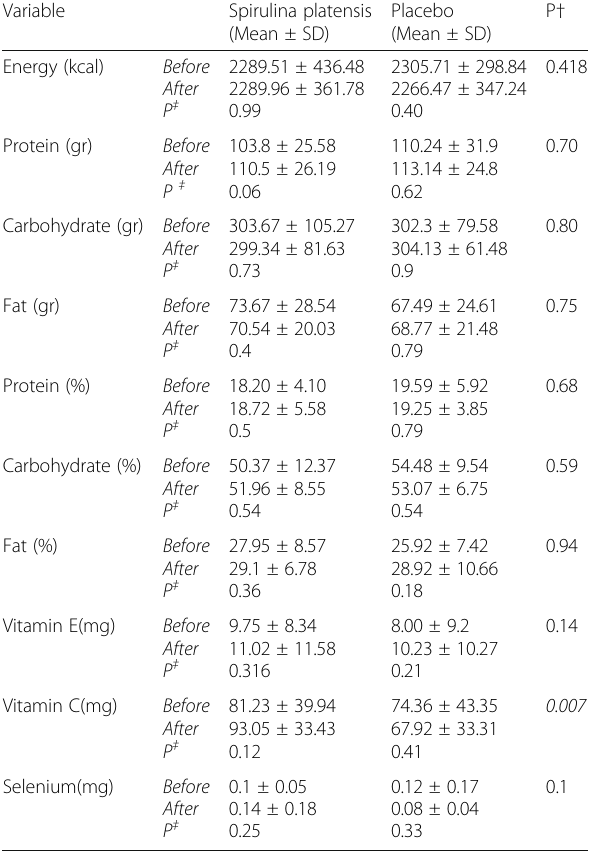
Table 3 Dietary intake of energy, macro and micronutrients